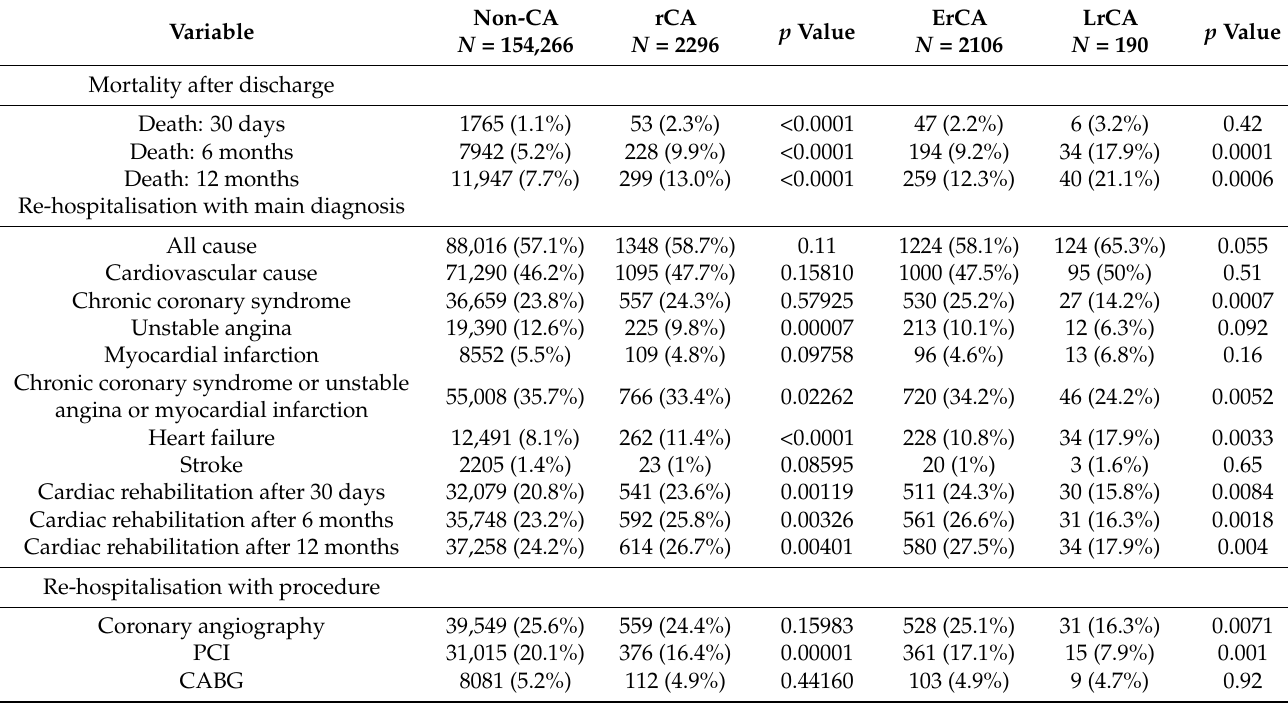
Table 5. One-year follow-up outcomes of patients without cardiac arrest and with ErCA and